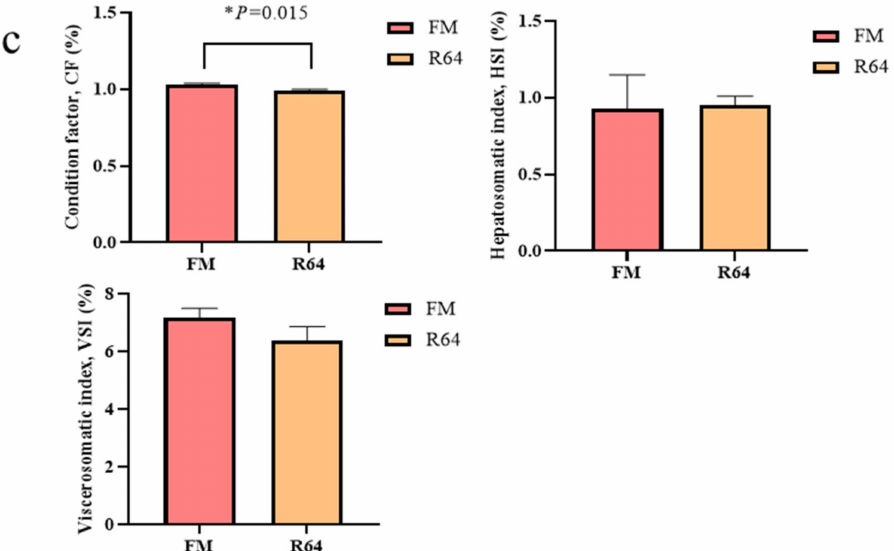
Figure 2. Effects of fishmeal replacement by low-gossypol cottonseed meal on the growth perfor- mance of juvenile S. sihama. ( a ): growth index, ( b ): feed utilization, ( c ): morphological indices.